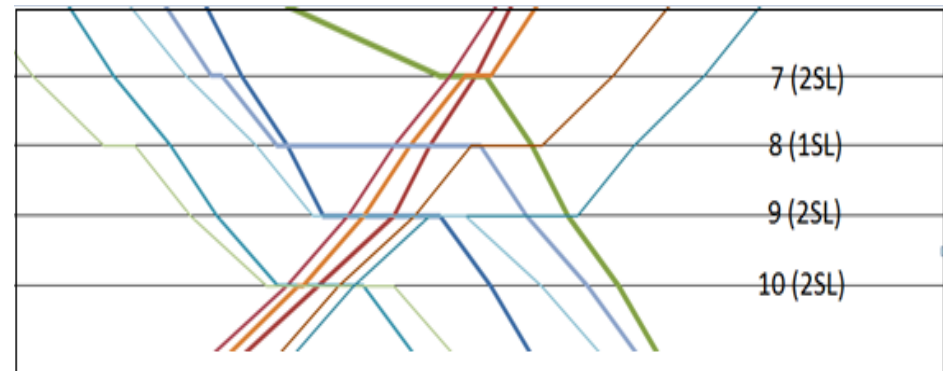
Figure 7. Congested area of Instance 1 is zoomed in. Table 13. Summary of the solution of Instance 1.